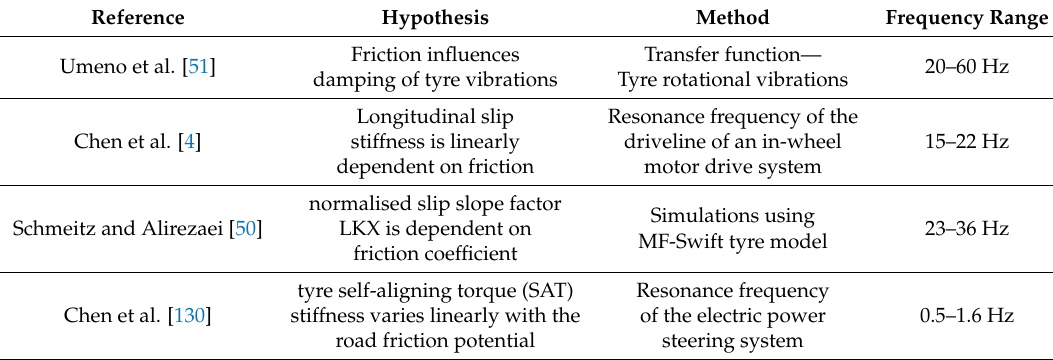
Table 6. Summary of low frequency vibration contributions on friction